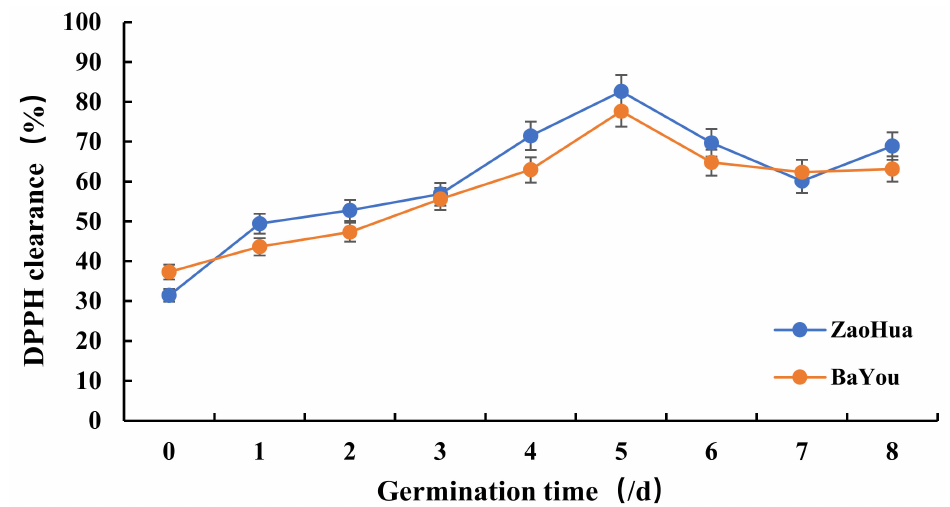
Figure 4. DPPH free-radical-scavenging rate of the AVN extract of the oats at different germina- tion